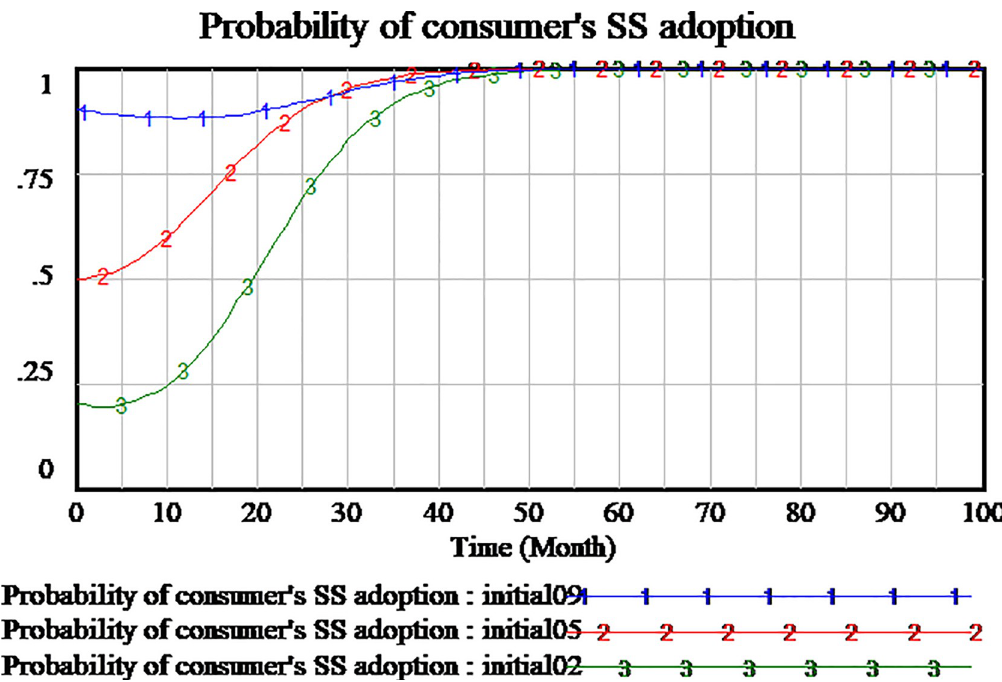
Fig 7. Impact of different initial strategies in consumer’s strategies adoption.